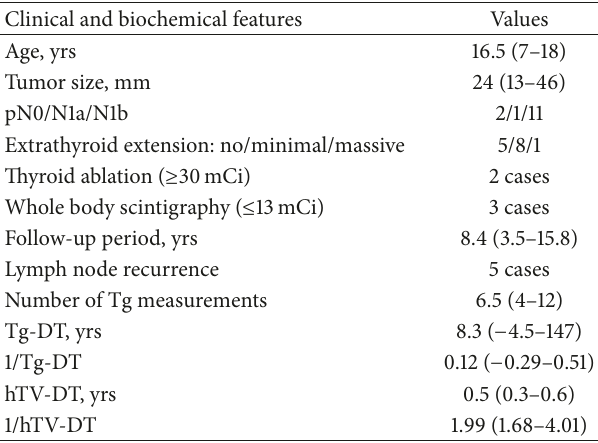
Table 1: Clinical and biochemical features of the 14 childhood or adolescent patients with papillary thyroid